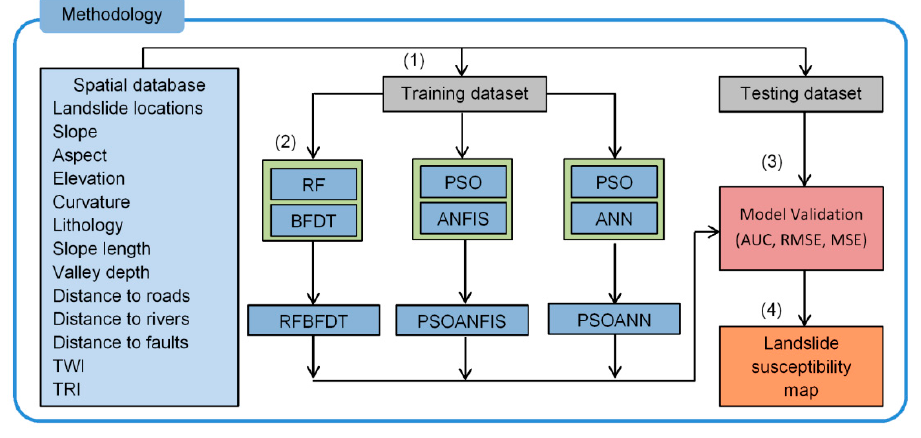
Figure 6. Methodology chart.